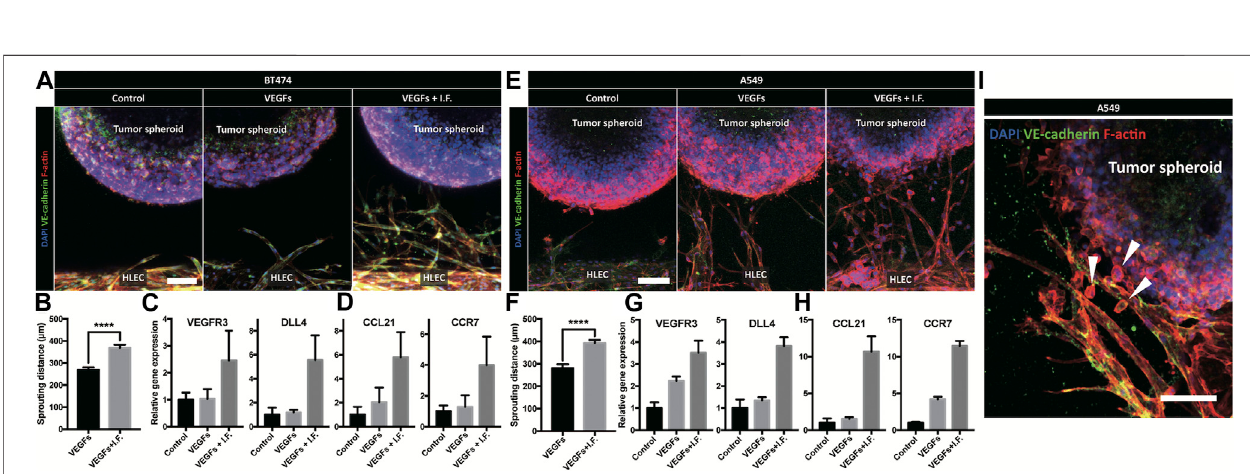
FIGURE 4 | Coculture model of tumor spheroid and lymphatic endothelial cell under a noninvasive cancer spheroid and a very low invasive cancer spheroid. (A) Immuno fl uorescent micrograph of the lymphatic vessel with a noninvasive cancer spheroid (BT474). Scale bar is 100 μ m. (B) Quanti fi cation of lymphatic sprouting toward tumor spheroid (BT474 and **** indicates p < 0.0001). (C, D ) Gene level expression related to (C) lymphatic sprouting and (D) tumor metastasis in BT474. (E) Immuno fl uorescent micrograph of the lymphatic vessel with a very low-invasive cancer spheroid (A549). Scale bar is 100 μ m. (F) Quanti fi cation of lymphatic sprouting toward a tumor spheroid (A549 and **** indicates p < 0.0001). (G, H) Gene-level expression related to (G) lymphatic sprouting and (H) tumor metastasis in A549. (I) Cancer invasion from tumor spheroid to peritumoral lymphatic vessel under interstitial fl ow and growth factor stimulation. Scale bar is 100 μ m. White arrowheads indicate a migrated cancer